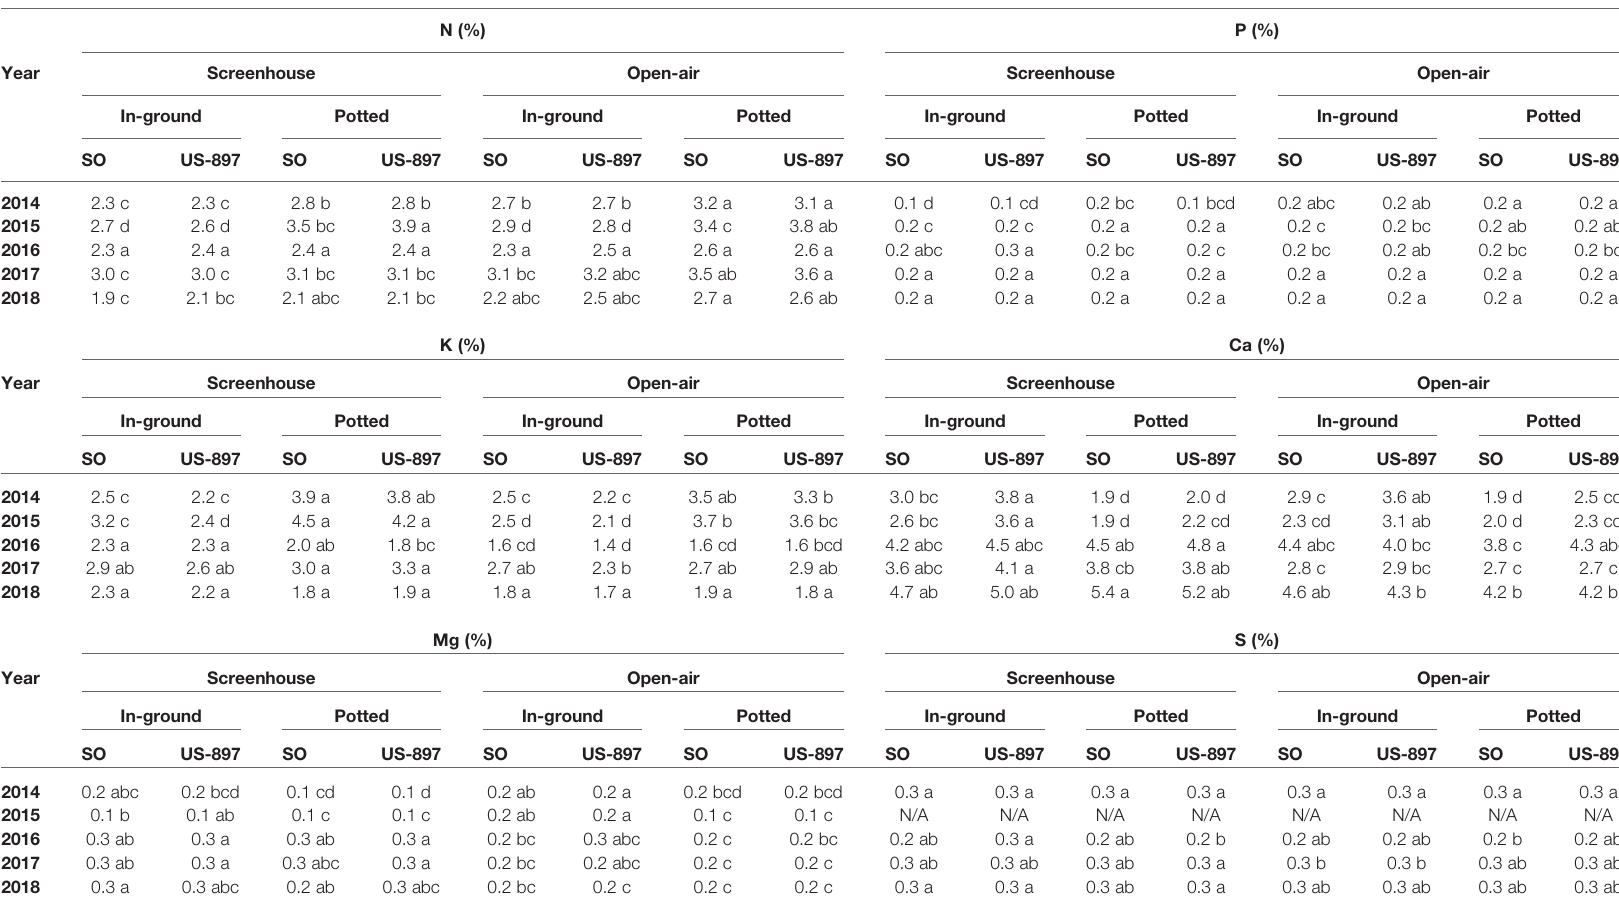
TABLE 1 | Leaf macronutrient content of “ Ray Ruby ” grapefruit trees cultivated under two production systems (screenhouse and open-air), two planting systems (in-ground and potted), and two rootstocks ( “ Sour Orange, ” SO, and “ US-897 ” ), with four replications arranged in a split-split-plot experimental design. Mean ± standard error of four replications. N (%) P (%) Year Screenhouse Potted In-ground Potted In-ground Potted SO